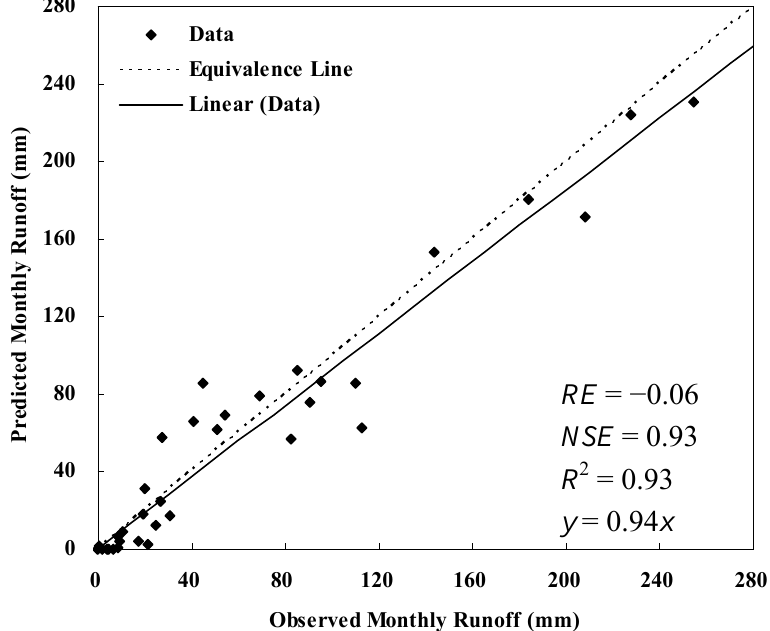
Figure 2. Comparison of observed and predicted monthly runoff at the Wuxi hydrological station during validation year